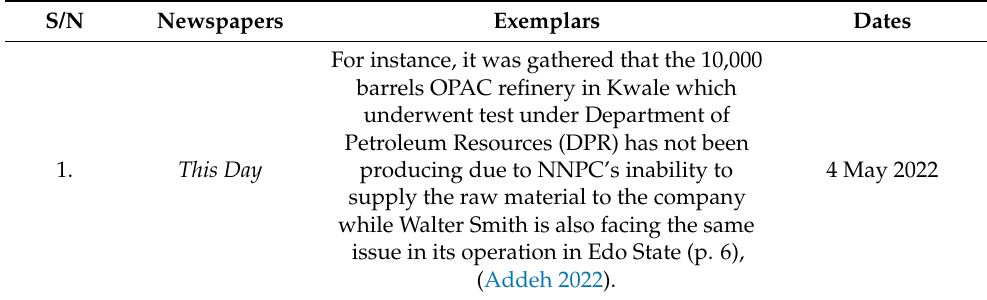
Table 4. Obfuscation of